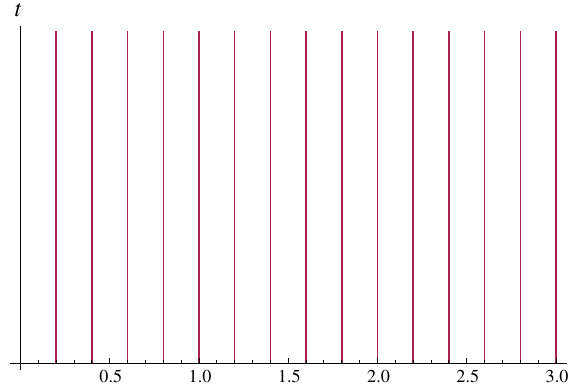
Fig. 1 The geometry of the PDEs in the MOL. The v i (τ) is defined along the